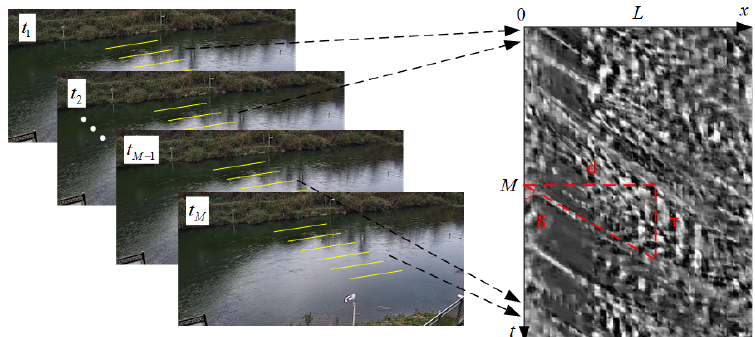
Figure 1. Generation of a space-time